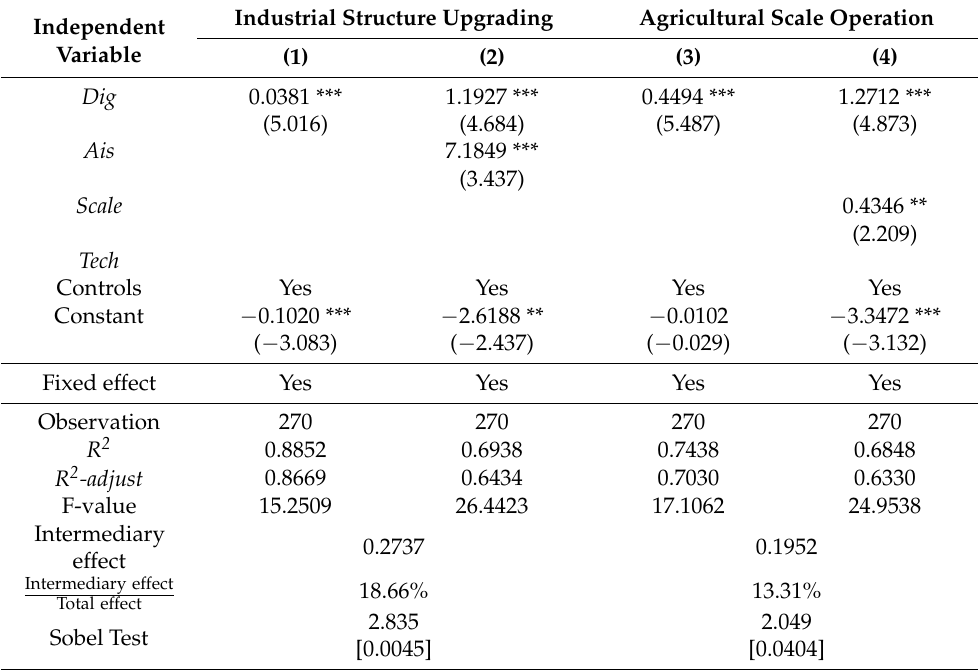
Table 7. Conduction mechanism regression